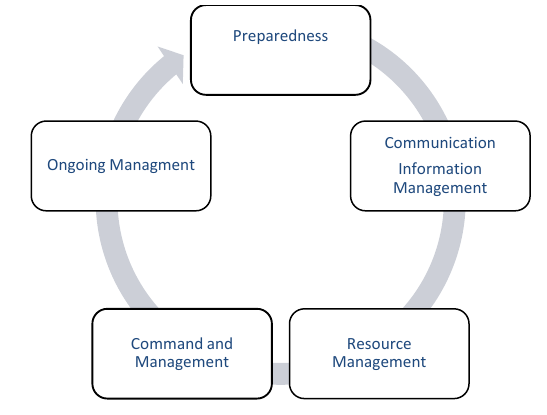
Figure 1. Components of NIMS Adapted From the National Incident Management System, 2008.